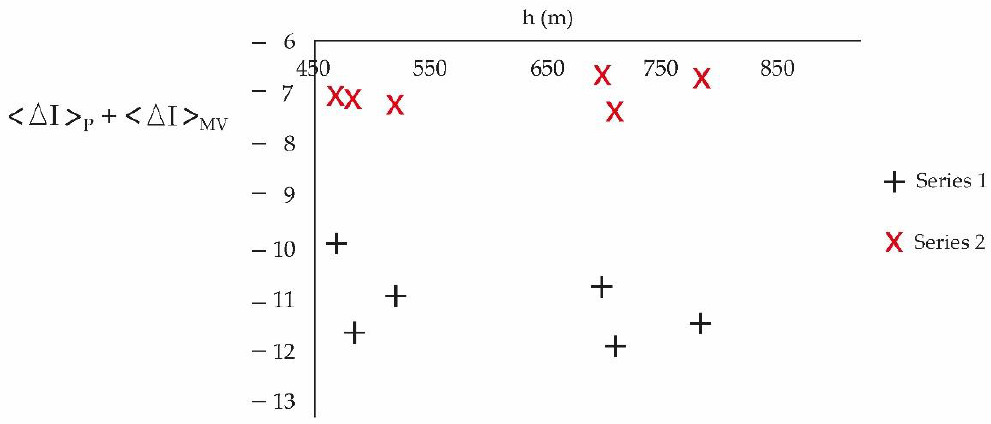
Figure 8. Series 1 corresponds to the loss of information for the period 2010 – 2013 and Series 2 corresponds to the loss of information for the period 2017 – 2020. This last period loses information faster (it is more chaotic).